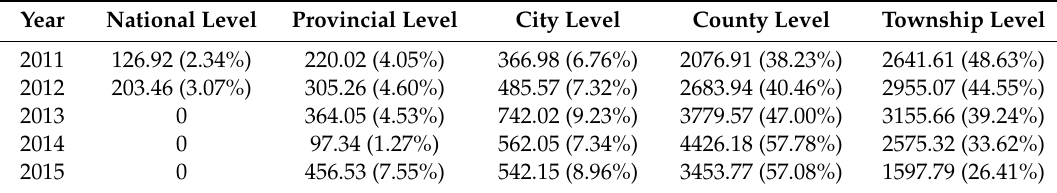
Table 2. Di ff erent investment levels of family planning investment in Shandong province (RMB million) (Percentage in total